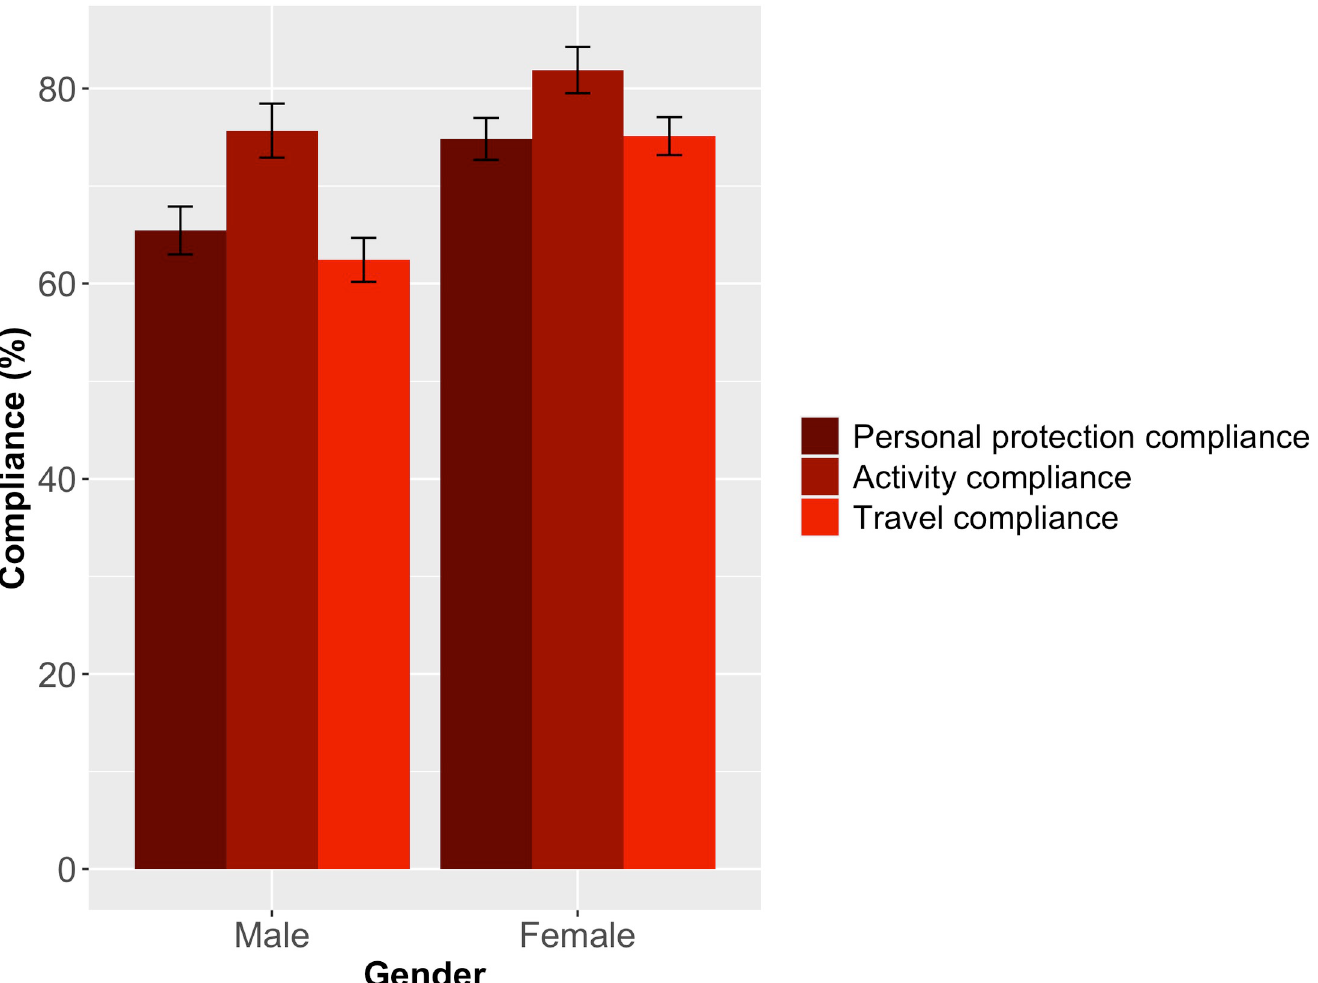
Fig 1. Mean compliance for each compliance component by gender (Protection measures: KW χ 2 = 8.327, d.f. = 1, p < 0.001, Activity: KW χ 2 = 2.665, d.f. = 1, p > 0.05, Travel measures: KW χ 2 = 23.285, d.f. = 1, p <